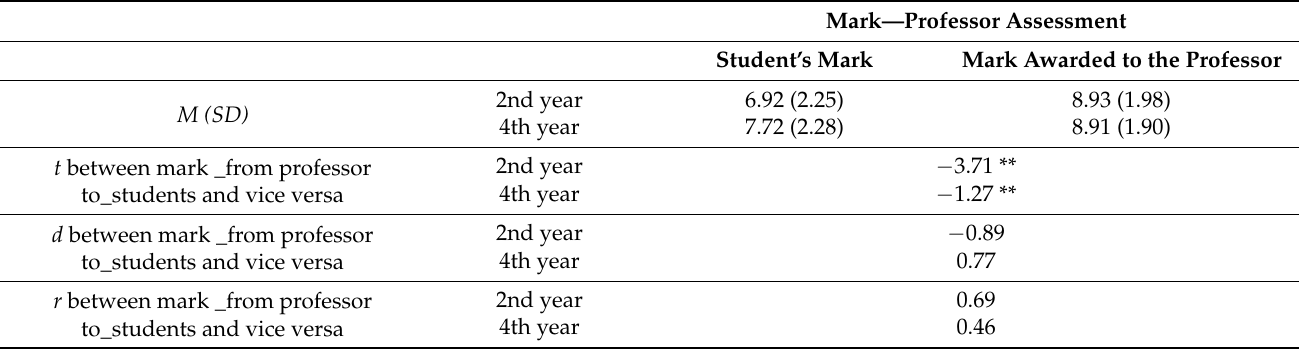
Table 4. Analyses of the students’ final marks and marks awarded to the